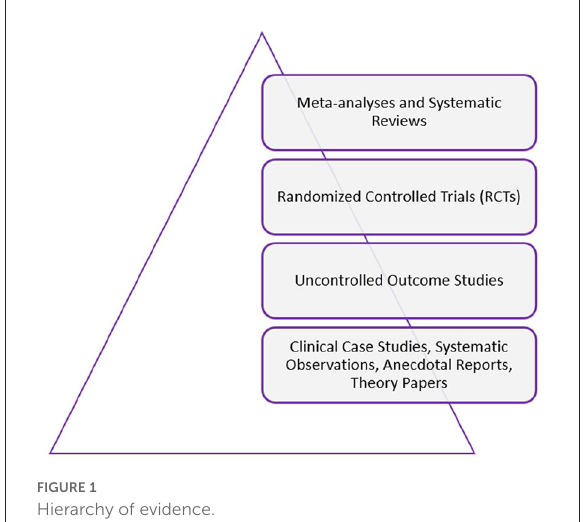
FIGURE1 Hierarchy of